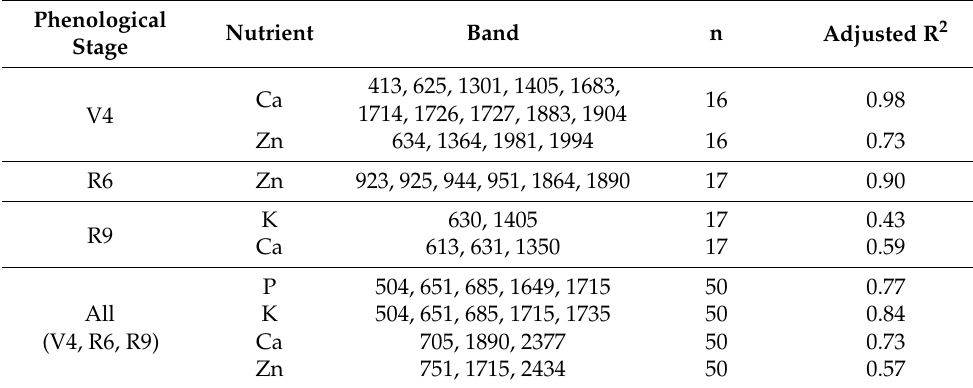
Table 4. Spectral bands selected for calibrating the PLSR models.